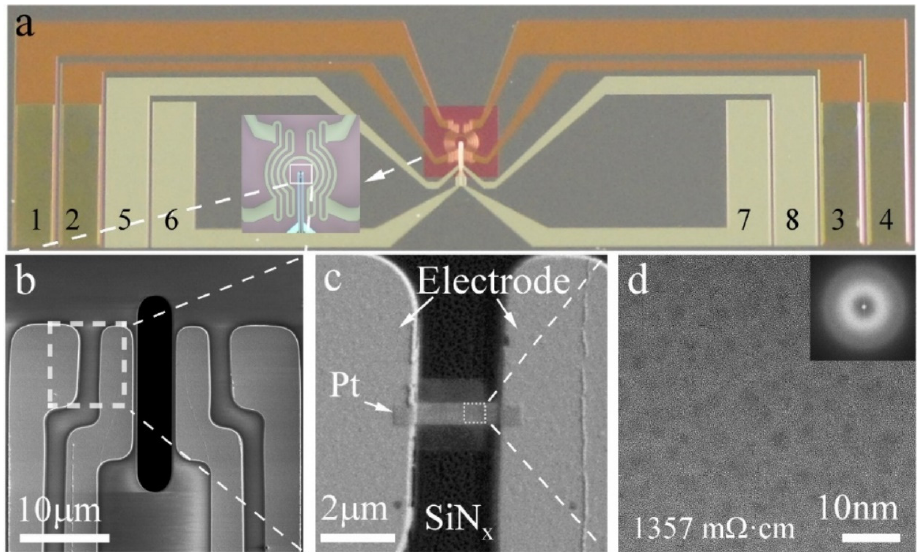
Figure 1. ( a ) Schematic of nano-chip for in situ heating and biasing together in transmission electron microscopy (TEM), in which, electrodes 1, 2, 3, and 4 are for heating, and electrodes 5, 6, 7, and 8 are for biasing. ( b ) Enlarged biasing electrodes. ( c ) Pt interconnector deposited between two electrodes on SiN membrane. ( d ) High resolution electron microscopy (HREM) image of the as-deposited Pt interconnector with inset of its corresponding Fast Fourier Transform (FFT) pattern revealing its amorphous structure.